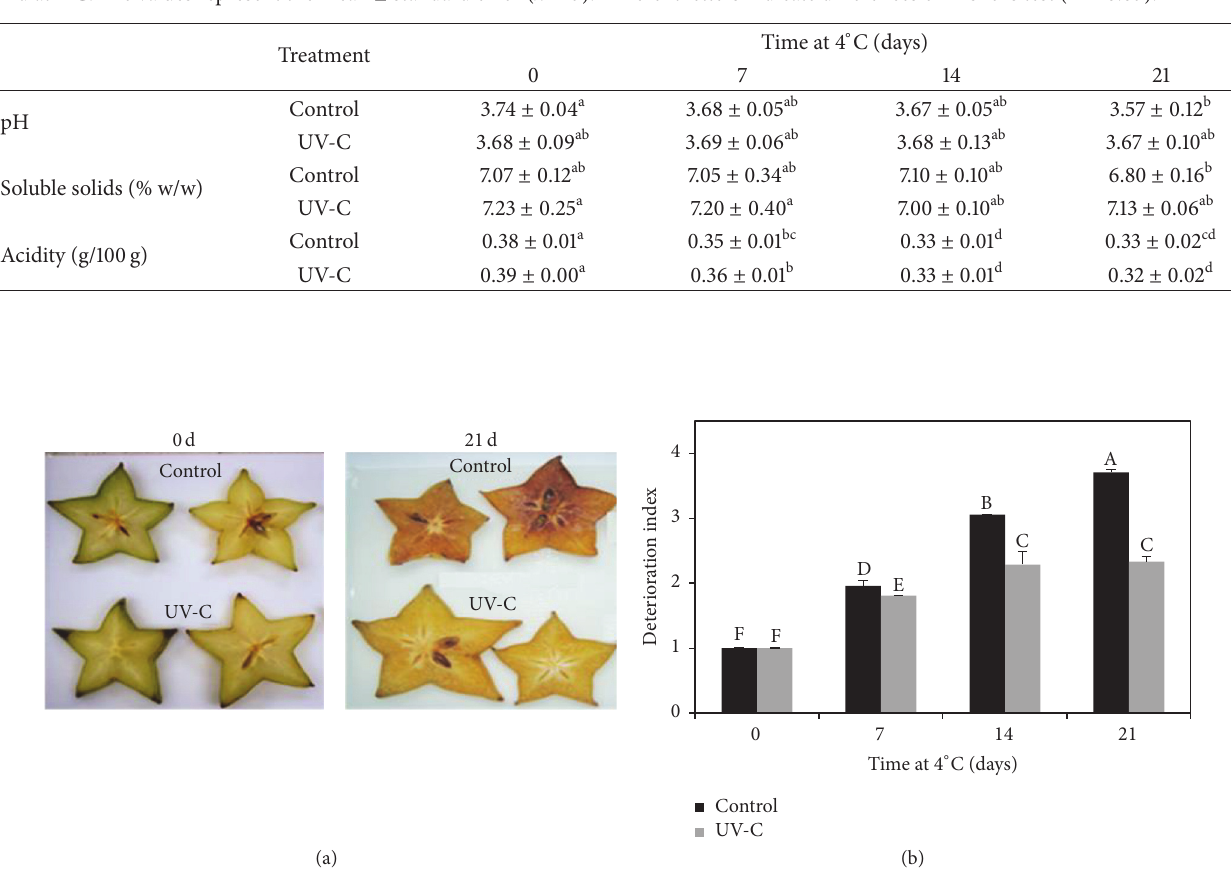
Figure 2: (a) Appearance and (b) deterioration index in control and UV-C treated (12.5kJ m −2 ) carambola slices stored during 21d at 4 ∘ C. Bars represent the standard error ( 𝑛 = 3 ). Different letters indicate significant differences on Fisher’s test ( 𝑃 < 0.05 ).